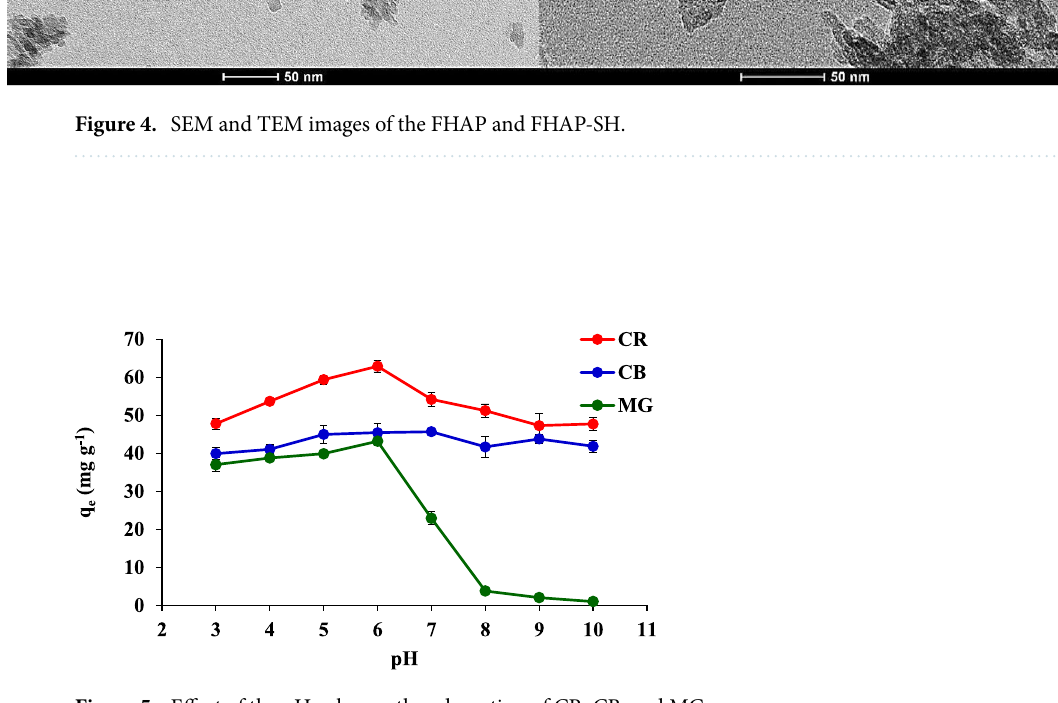
Figure 5. Effect of the pH value on the adsorption of CR, CB, and